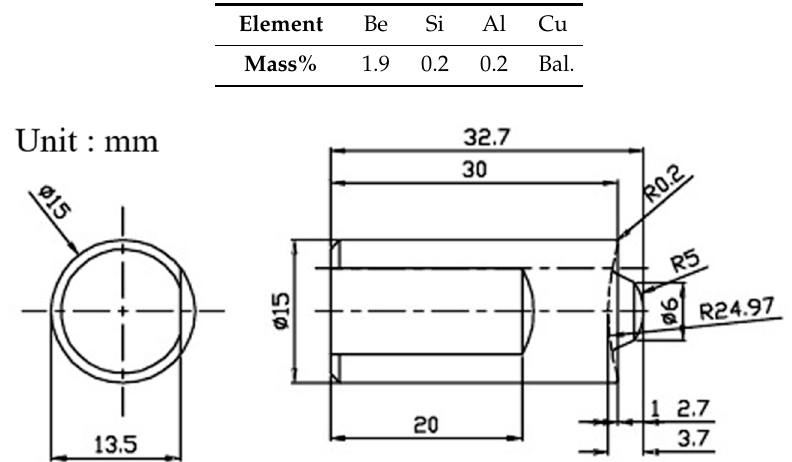
Table 1. Chemical composition of the beryllium-copper alloy used in this work.